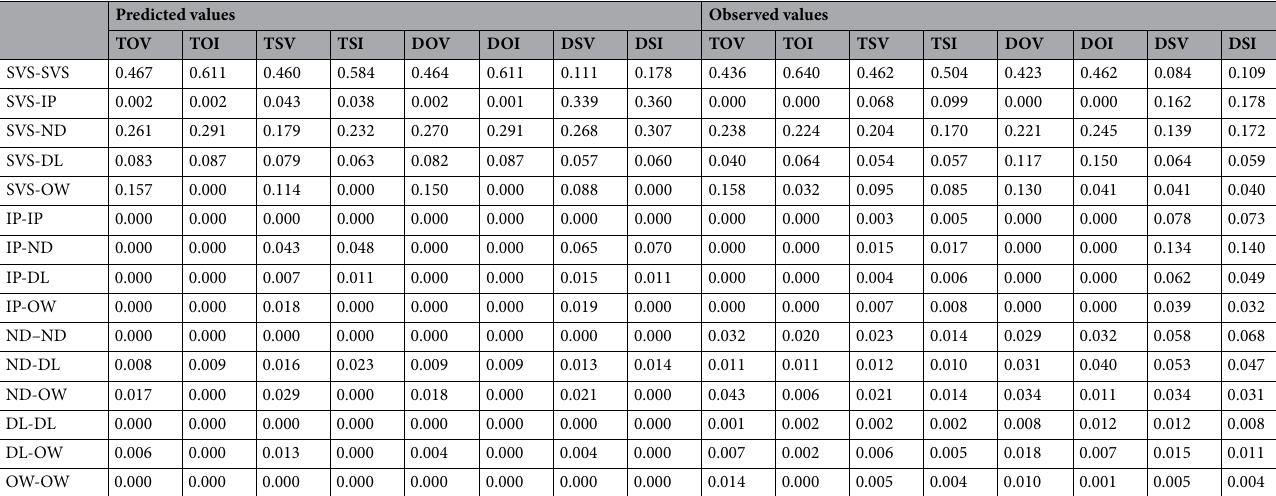
Table 9. Predicted and experimentally observed shift probabilities between AOIs in the eight experimental conditions.